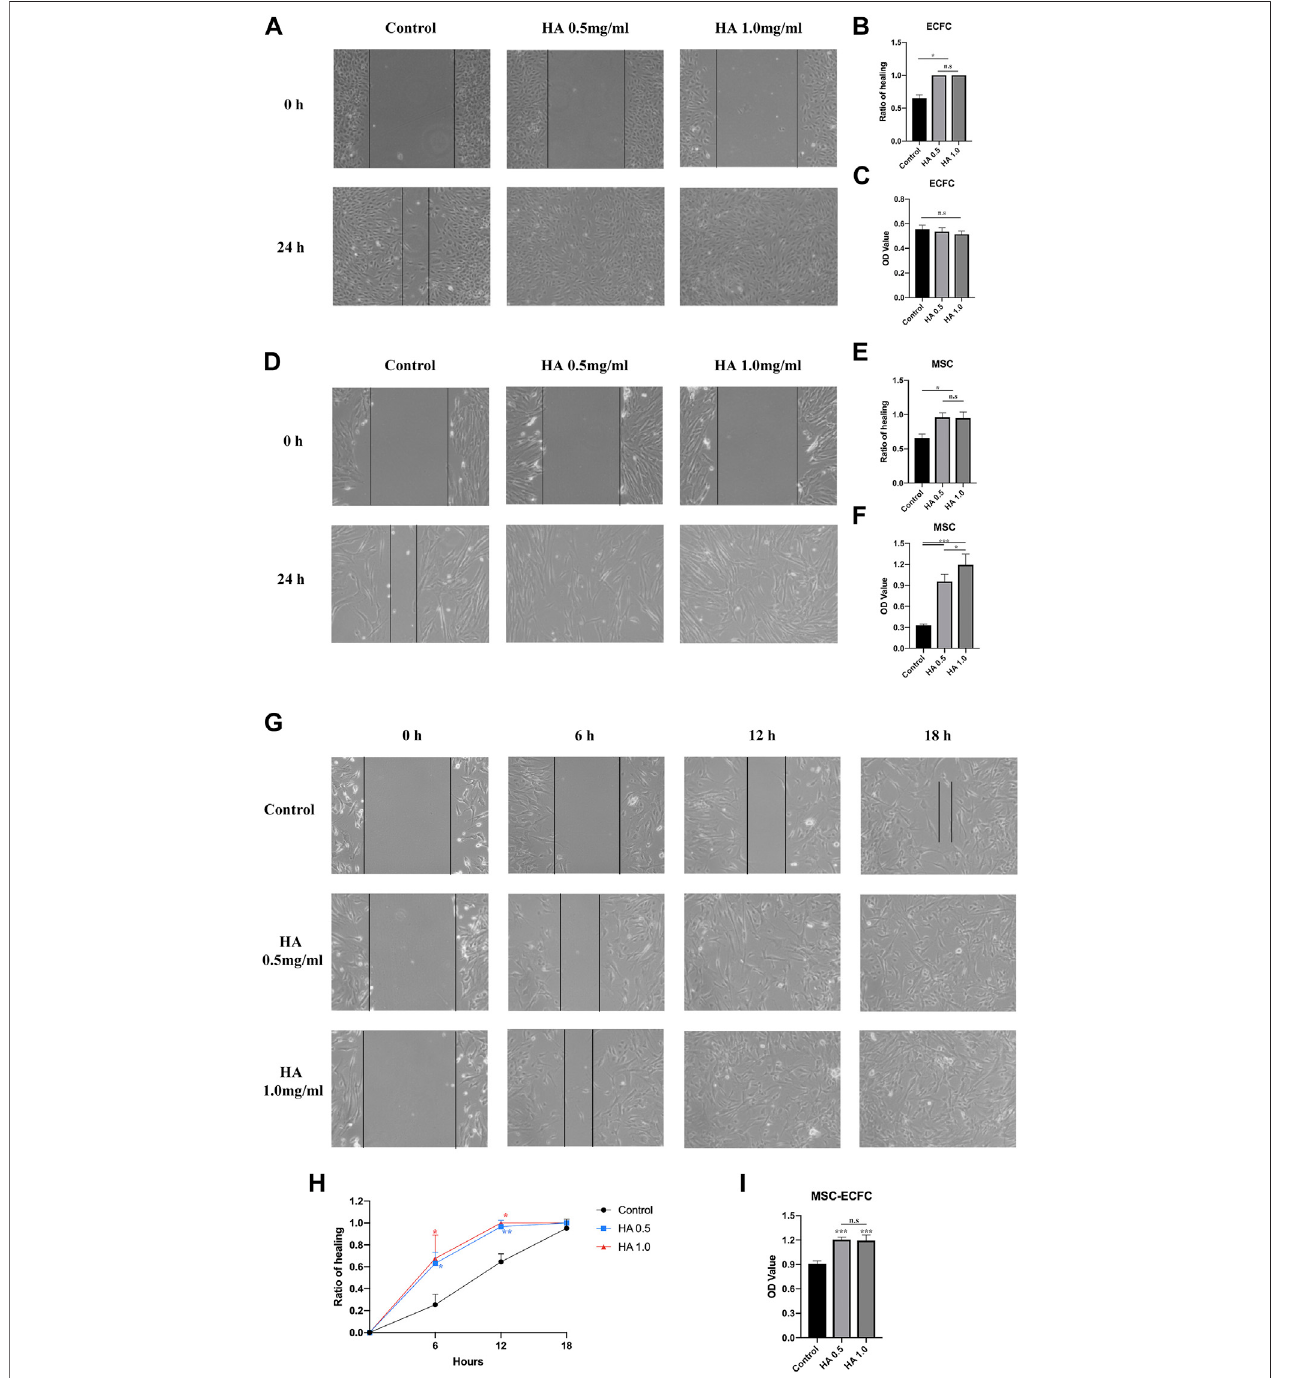
FIGURE1| EffectofHAdilutionsoncellviabilityandmigration.Following24 hofexposuretoHA,woundhealingassayswereperformedtoassessthemigrationof ECFCs (A,B) , MSCs (D,E) and MSCs-ECFCs (G,H) . CCK-8 assays were performed to assess the proliferation of ECFCs (C) , MSCs (F) , and MSCs-ECFCs (I) . ( n = 3 independent experiments. Error bars: mean ± SD. * p < 0.05, ** p < 0.01, *** p < 0.001).